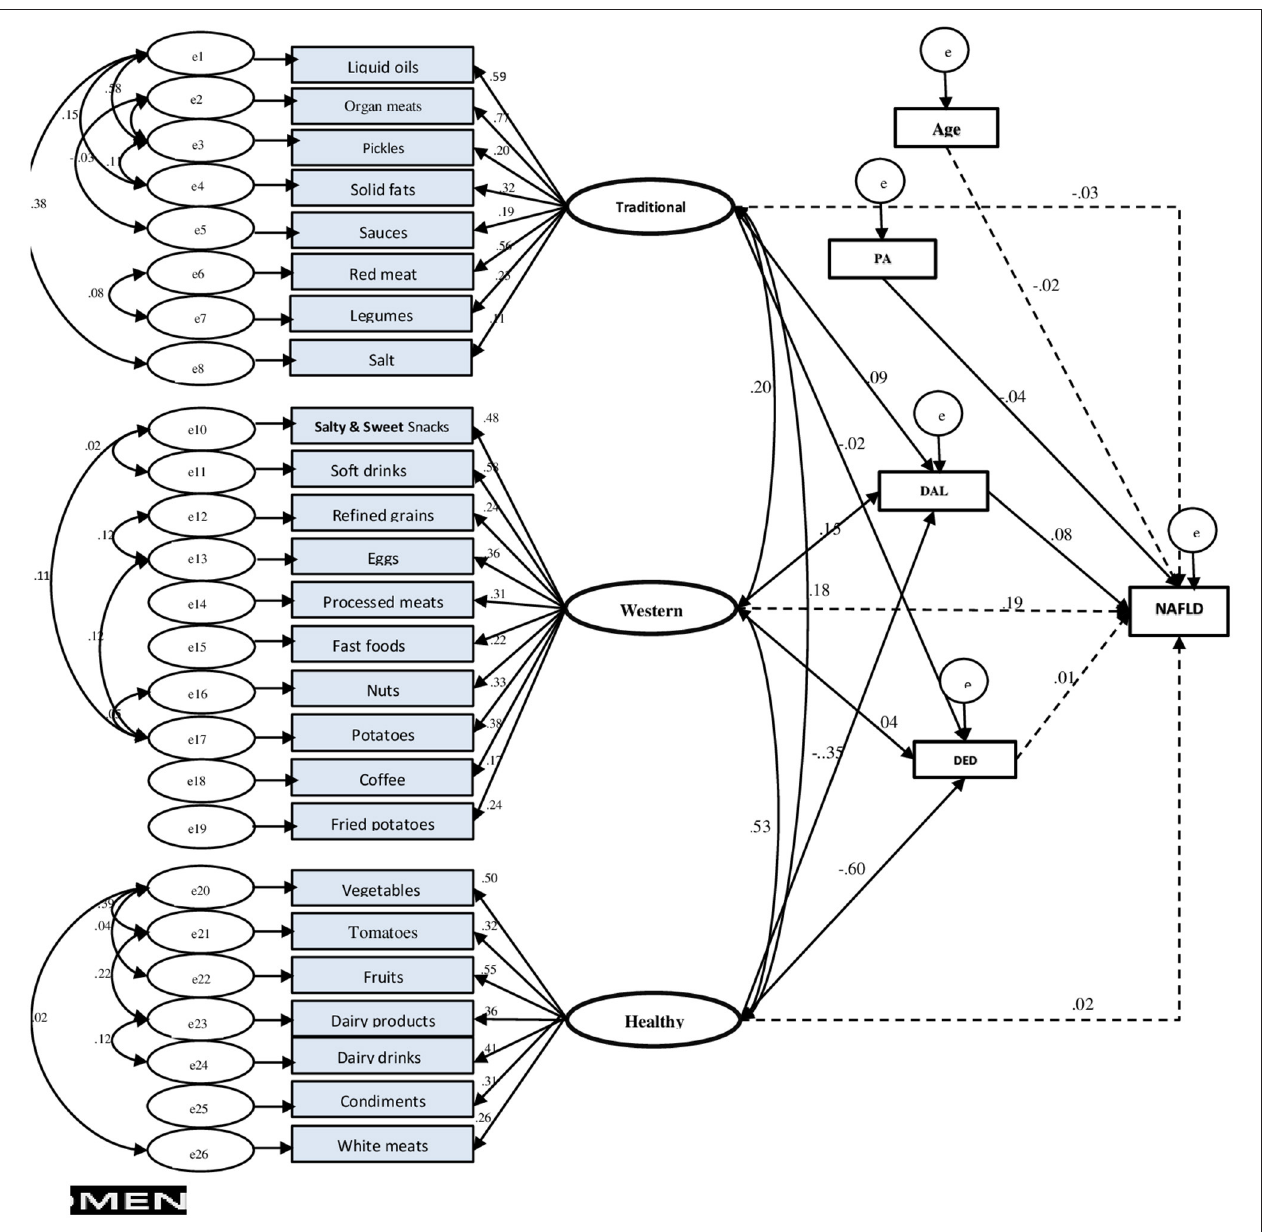
FIGURE 4 | Final structural equation model (SEM) in men. Fit indices of SEM model: GFI = 0.94, AGFI = 0.93, SRMR = 0.04, RMSEA = 0.03. NAFLD, non-alcoholic fatty liver disease; PA, physical activity; DED, dietary energy density; DAL, dietary acid